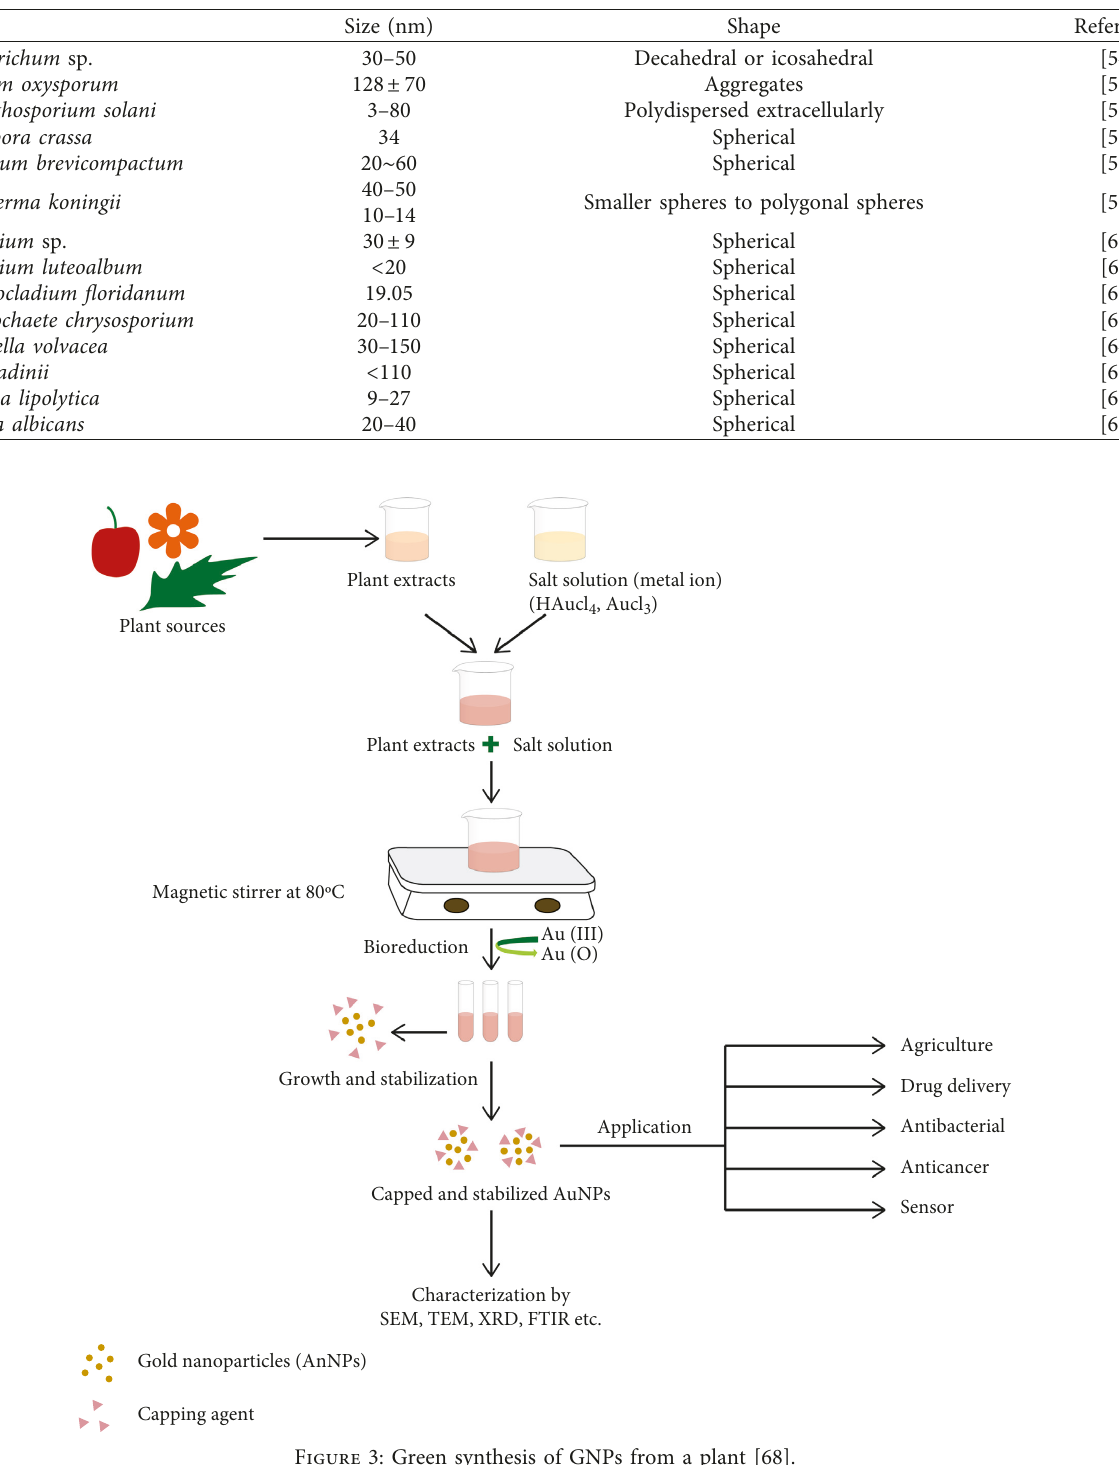
Table 2: Fungi synthesize gold nanoparticles.